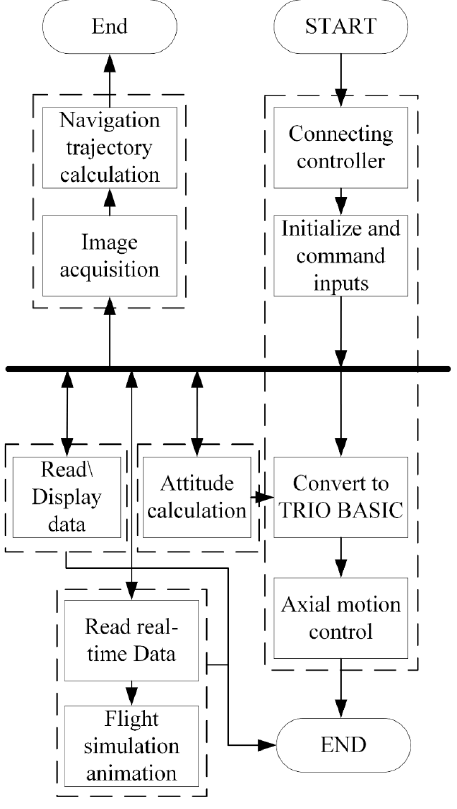
Figure 14. Software